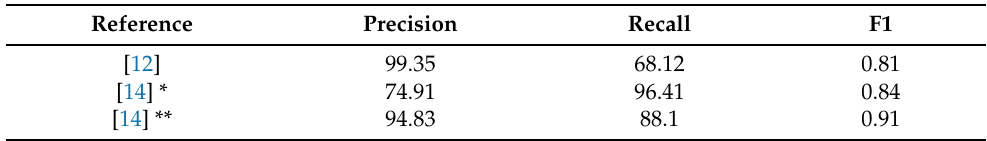
Table 4. Comparison of cited works using the SWaT data-set. * Indicates reported results based on recall. ** Indicates reported results based on F1